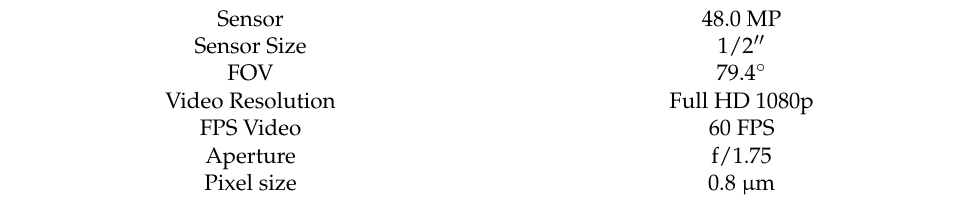
Table 3. Redmi Note 8T camera features [45].